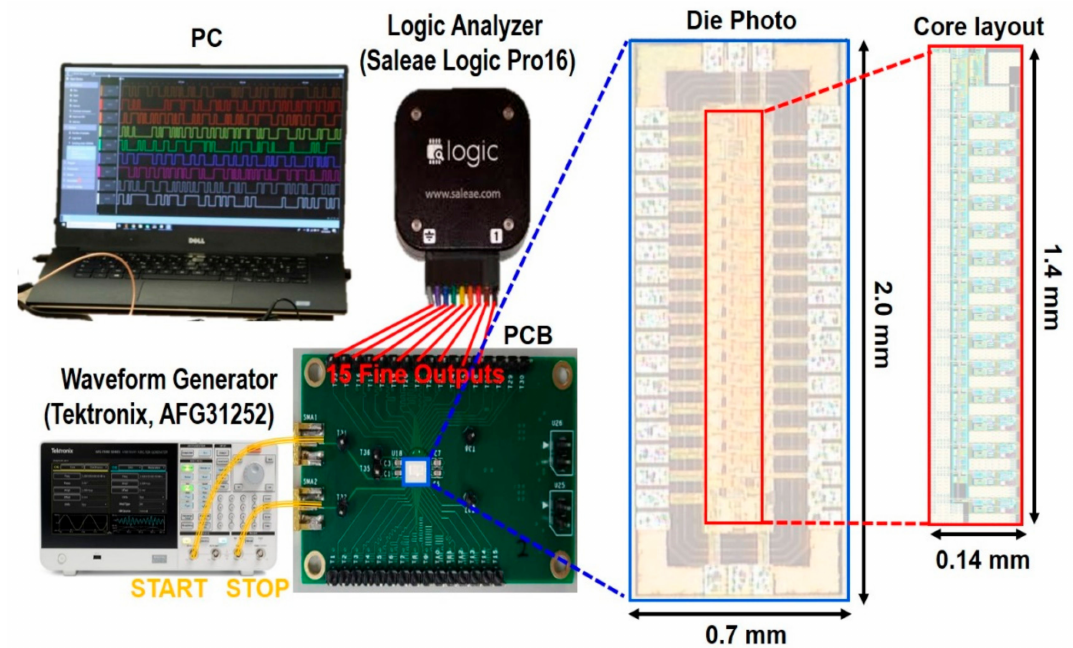
Figure 6. Chip photograph of the I-TDC and its test